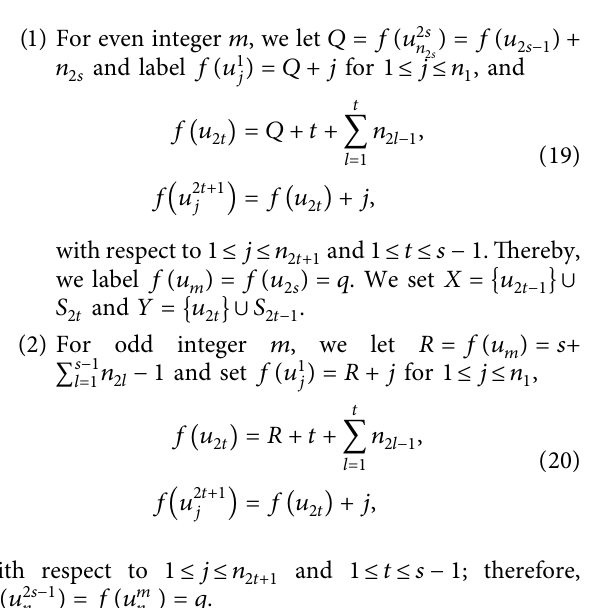
Figure 2: (a) A tree T admits a strongly c-elegant labelling. (b) Another tree T 1 example of Theorem 8 based on two graphs shown in